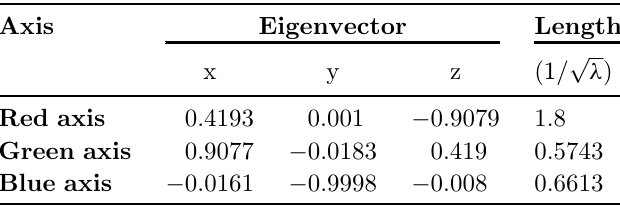
Table 5. Parameters of the ellipsoid resulting from the planning of the 4th trajectory with duration 1.4 s, expressed with respect to the tool frame.